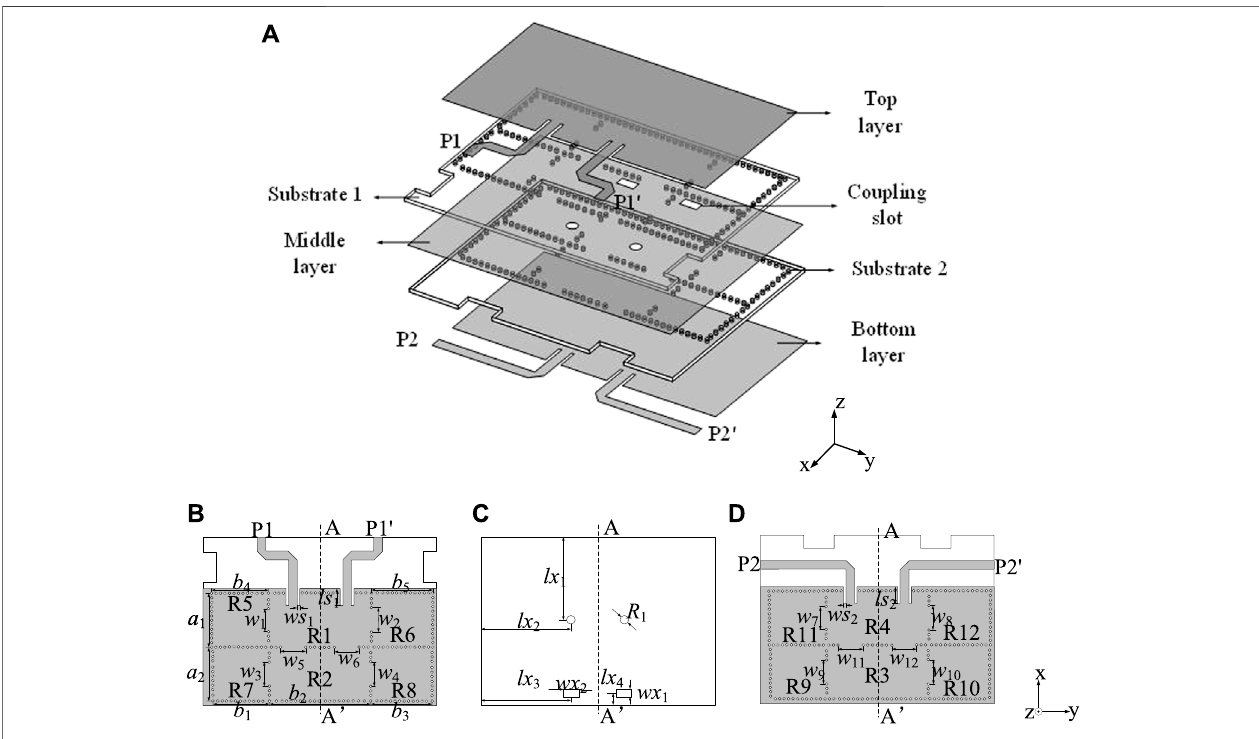
FIGURE 1 | Physical con fi guration of proposed balanced tri-band BPF. (A) 3-D view, (B) top layer, (C) middle layer, (D) bottom layer.